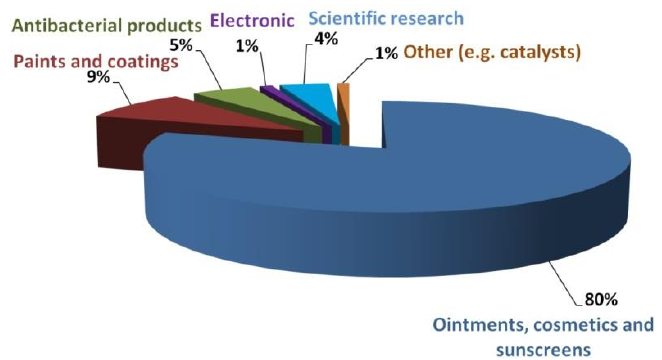
Figure 5. Estimated demand for ZnO NPs on the market in terms of their applications. The chart was prepared based on data from [115].